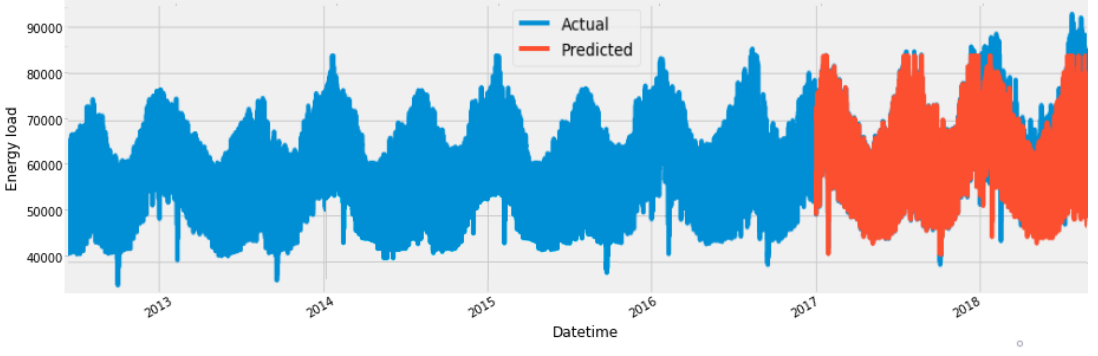
Figure 15. Overall prediction using hybrid Model.